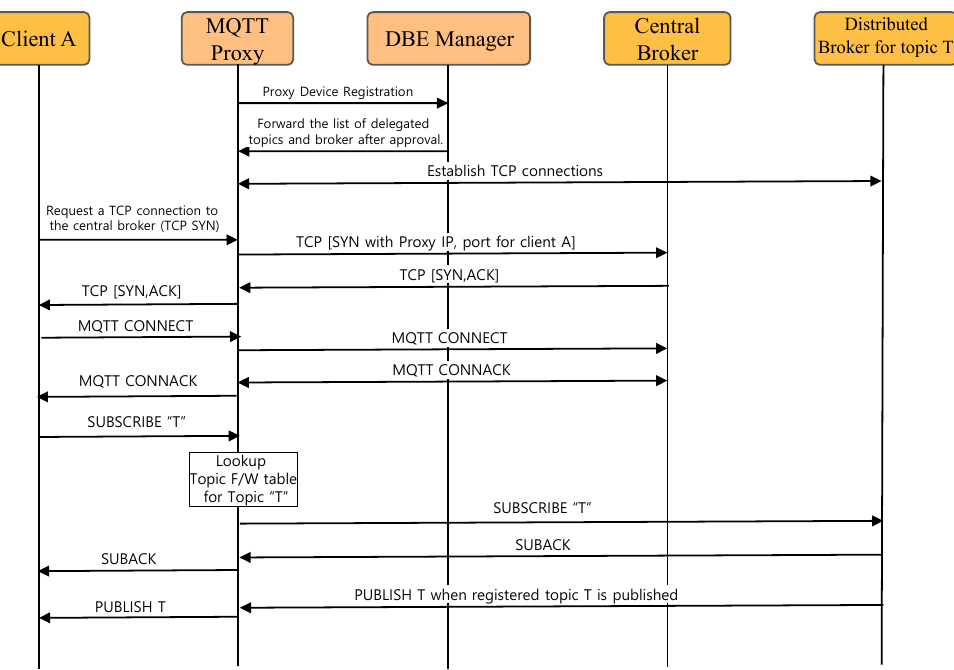
Figure 7. Operation of MQTT proxy-based client connection and